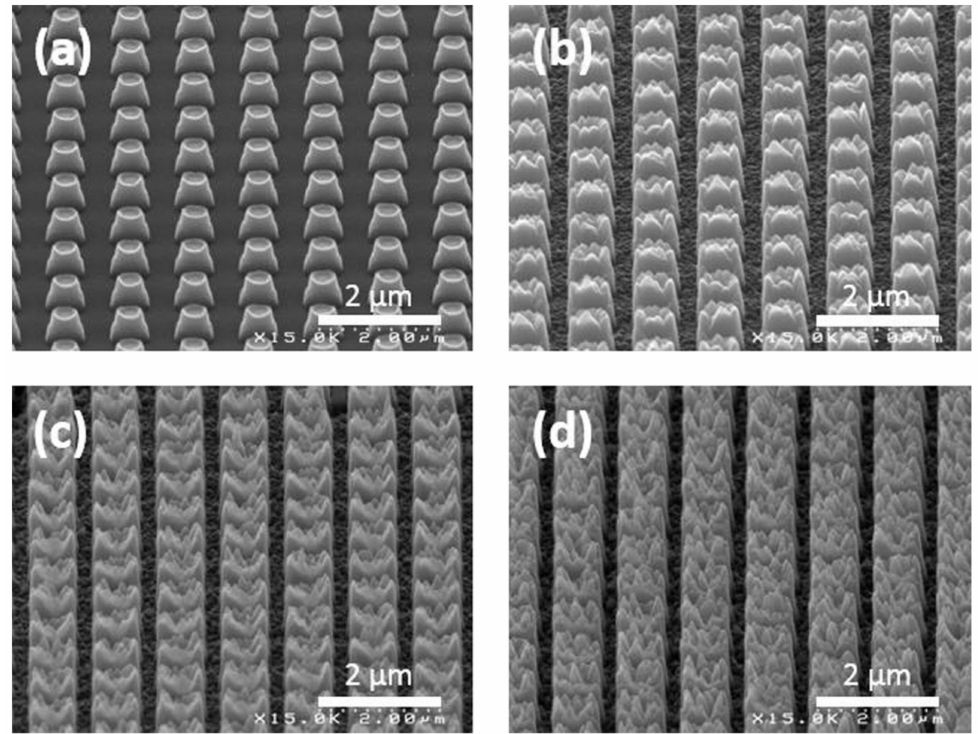
Figure 22. SEM images of ( a ) a native nanoimprinted film of FEP. Roughened dots were obtained by plasma treatment at 1000 W ( b ), 1600 W ( c ) and 1800 W ( d ). (Reprinted from [137] with permission from